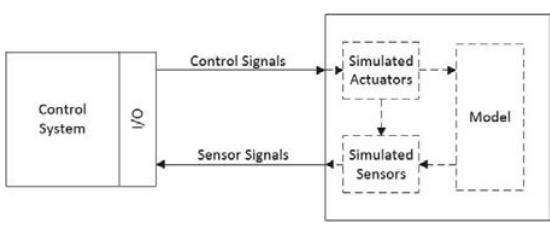
Figure 9. A hardware-in-the-loop configuration.